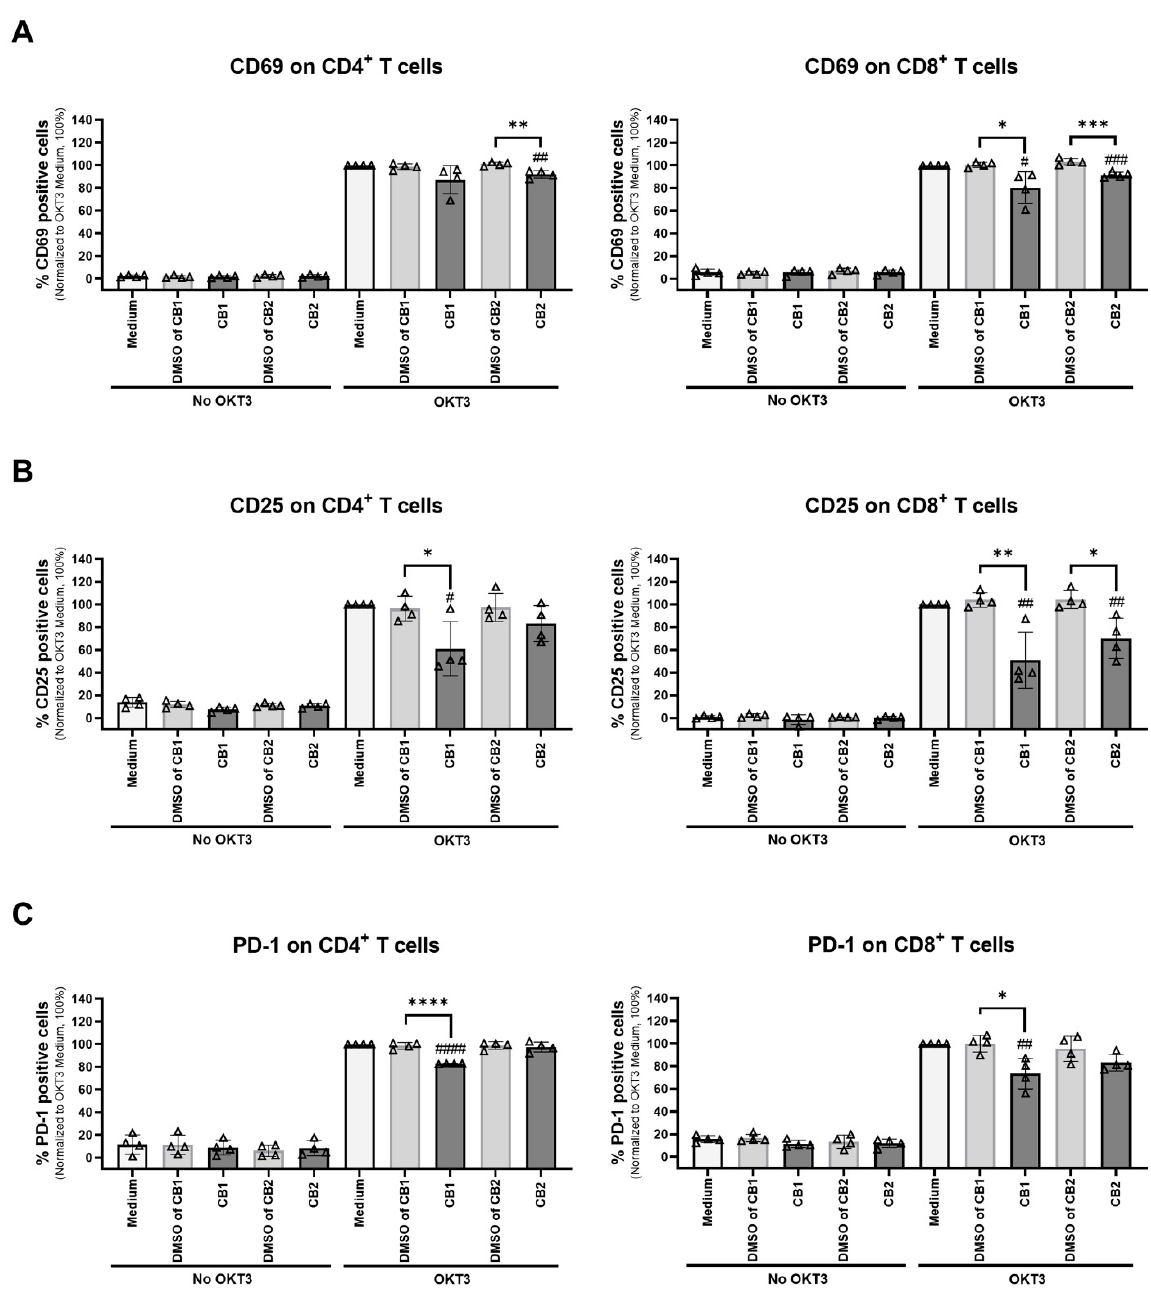
Figure 3. Different effects of CB1 and CB2 agonists on T cell activation molecules. PBMCs (n = 4) were activated with or without anti-CD3 mAb. We analyzed T cell activation markers in the presence of 20 µ M CB1 agonist ACEA or 5 µ M CB2 agonist GW833972A and compared the results with those of the relevant concentrations of DMSO or medium control. The percentage of CD69- ( A ) and CD25- ( B ) expressing CD4 + T cells and CD8 + T cells was detected on Day 1. The percentage of PD-1- ( C ) expressing CD4 + T cells and CD8 + T cells was detected on Day 3. The data were analyzed using flow cytometry as the percentage of positive cells (% specific marker mAb staining–% isotype- matched control mAb staining). The bar graphs report the percentage of positive cells in the indicated conditions as mean ± SD. A triangle represents individual datum. Each individual datum was normalized relative to its medium control (OKT3 + Medium) as 100%. We used an unpaired t -test for comparison of the DMSO control and the tested conditions. * p < 0 . 05; ** p < 0 . 01; *** p < 0 . 001; **** p < 0 . 0001 . Unpaired t - test was used for comparison between the medium control and tested conditions. # p < 0 . 05; ## p < 0 . 01; ### p < 0 . 001; #### p < 0 . 0001 .